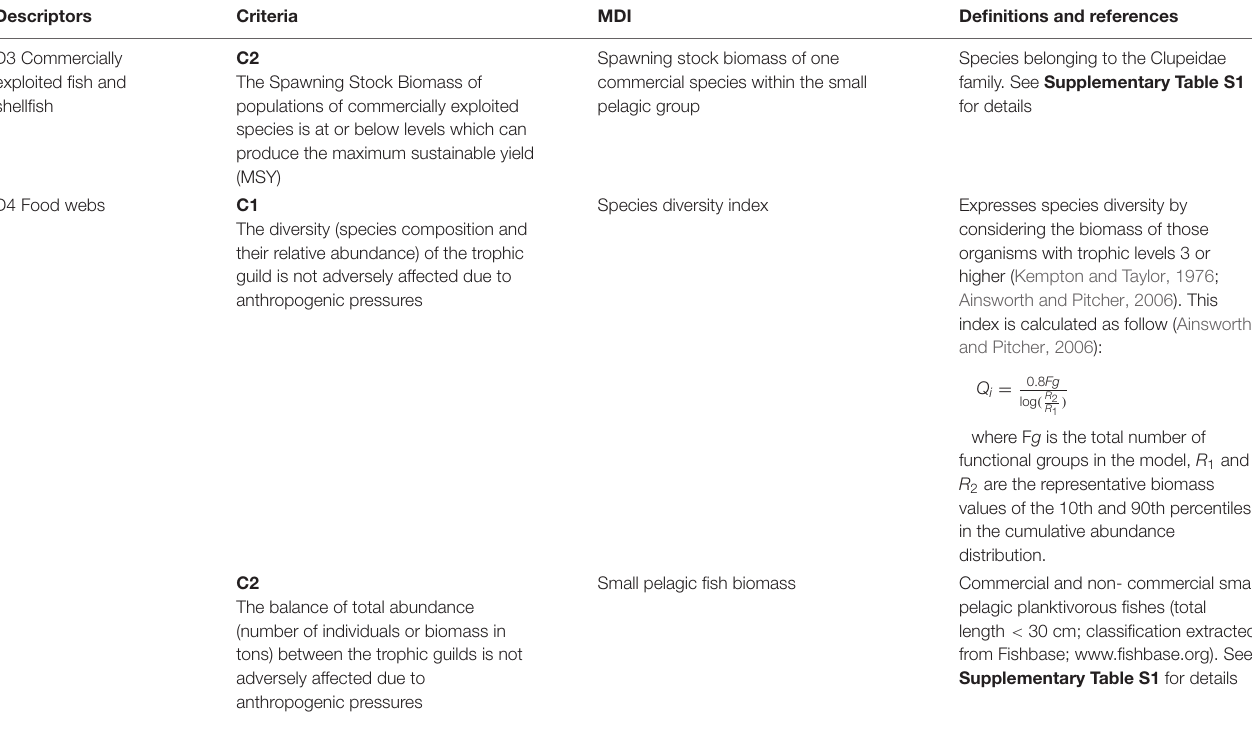
TABLE 2 | List of selected descriptors/criteria as defined by the MSFD (2017/848/EC) together with the modeled derived indicators (MDI), definitions and